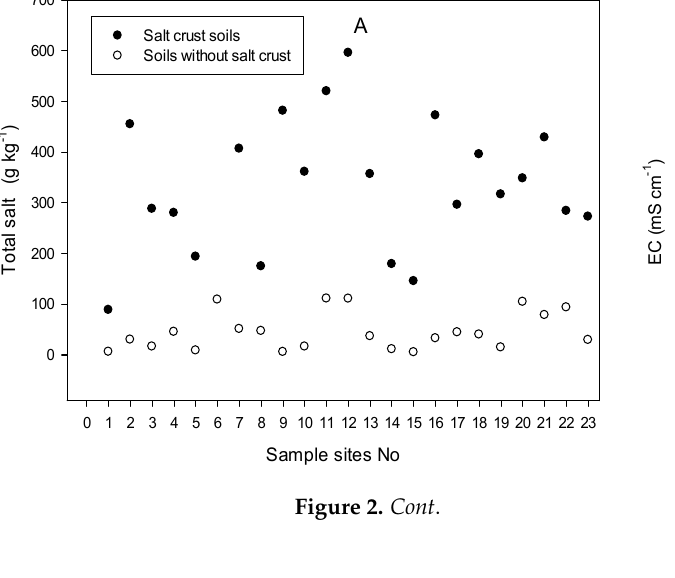
The * represents a significant difference between the soils with and without a crust.